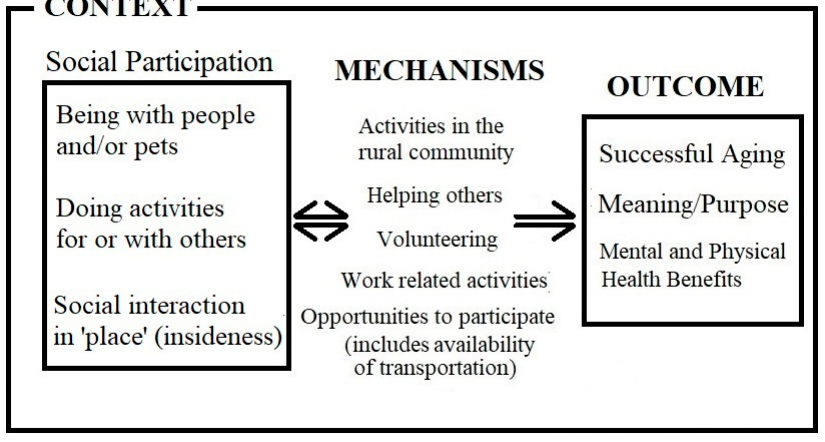
Figure 2. Social participation conceptual framework.